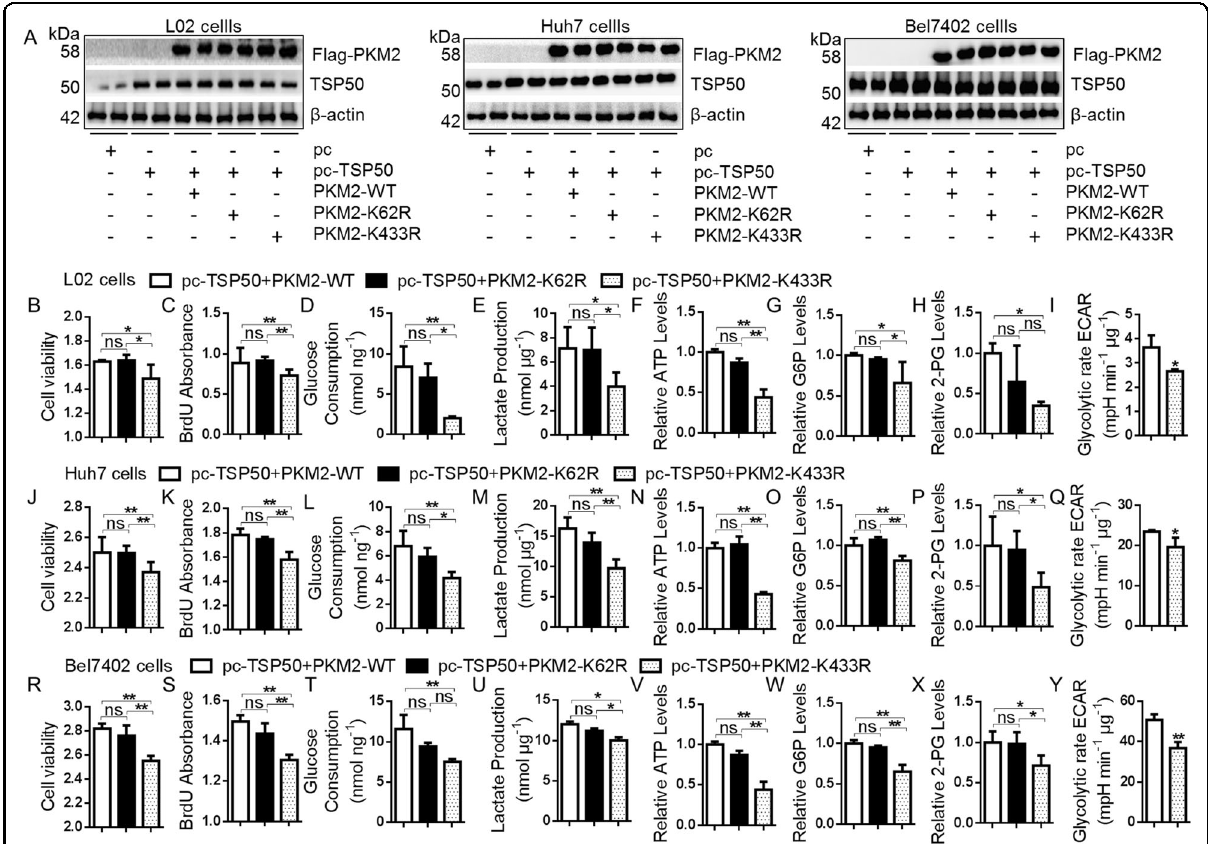
Fig. 7 TSP50 mediates the cell proliferation and aerobic glycolysis changes partially dependent on PKM2 K433 acetylation. A The pcDNA3.1-TSP50 and Flag-PKM2 WT, Flag-PKM2 K62R or Flag-PKM2 K433R mutant plasmids were co-transfected into L02, Huh7 and Bel7402 cells, respectively. B – Y The cell viability, BrdU absorbance, glucose consumption, lactate production, ATP levels, G6P levels, 2-PG levels and ECAR levels were detected. The aerobic glycolysis values were normalized to protein levels. N = 3 biologically independent replicates. One-way ANOVA statistical analysis was used. Data were presented as means ± s.d. *P < 0.05, ** P < 0.01. ns, no signi fi